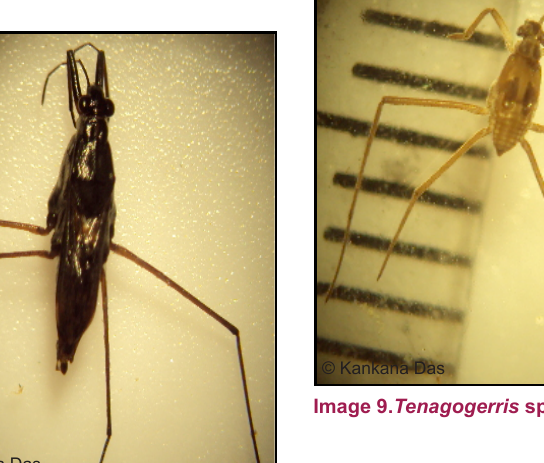
Image 5. Ranatra elongata